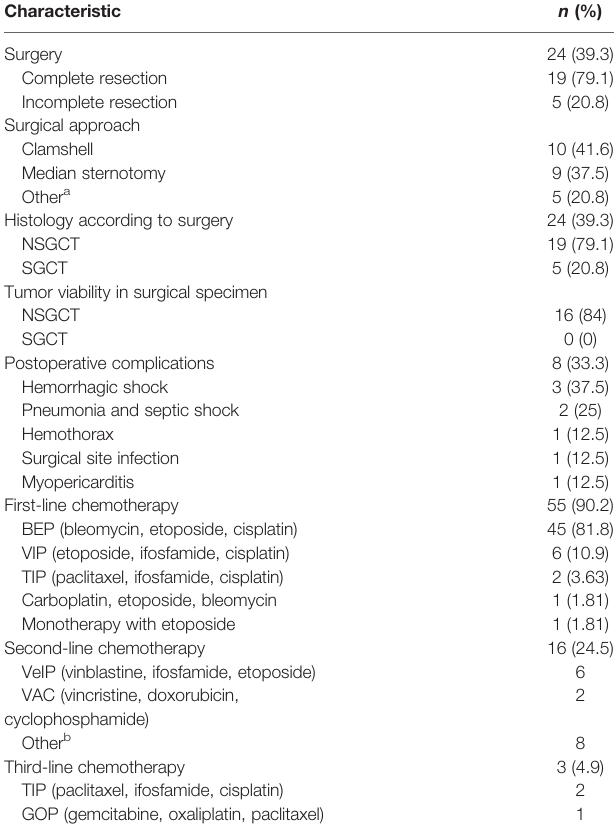
TABLE 2 | Treatment